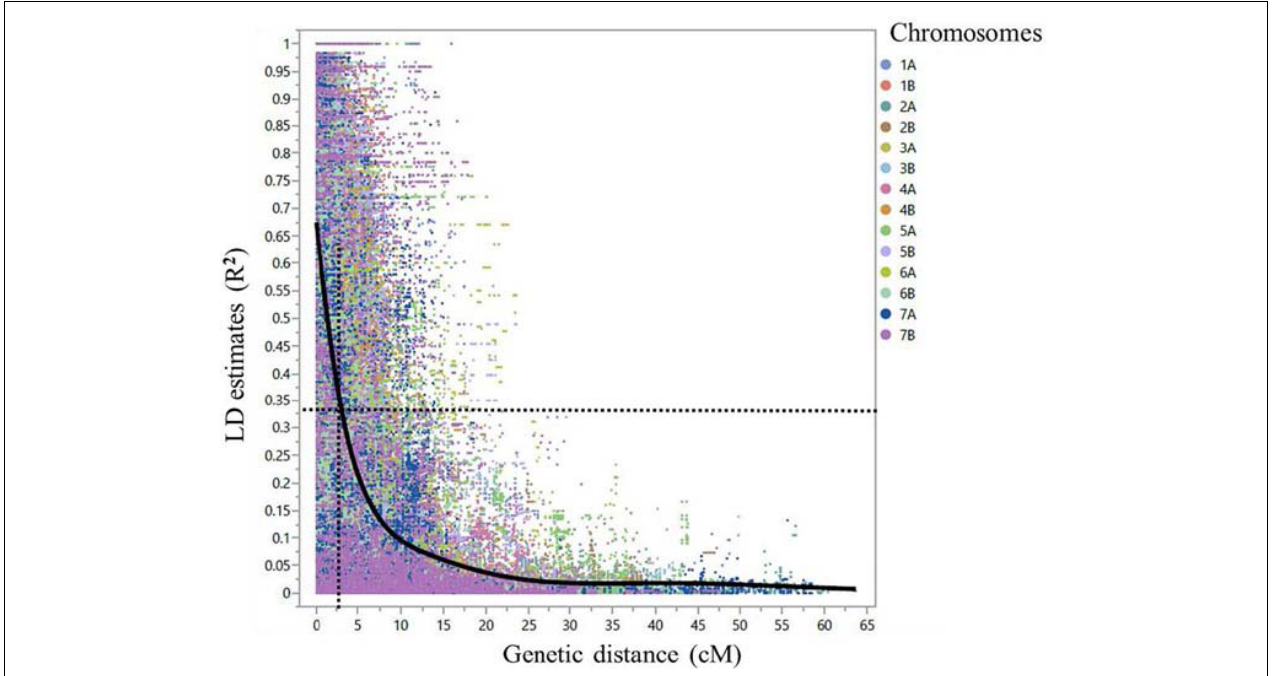
FIGURE 5 | Scatter plot demonstrating linkage disequilibrium (LD) decay across the 14 durum wheat chromosomes for the 248 durum wheat genotypes. The LD estimate ( R 2 ) for pairs of SNPs was plotted against the corresponding genetic distance in centimorgan (cM) based on the tetraploid consensus map of Maccaferri et al. (2015). The dashed lines represent the LD decay that dropped by half at around 2.5 cM in average. TABLE 1 | Bayesian Information Criterion of association mapping models for each trait.